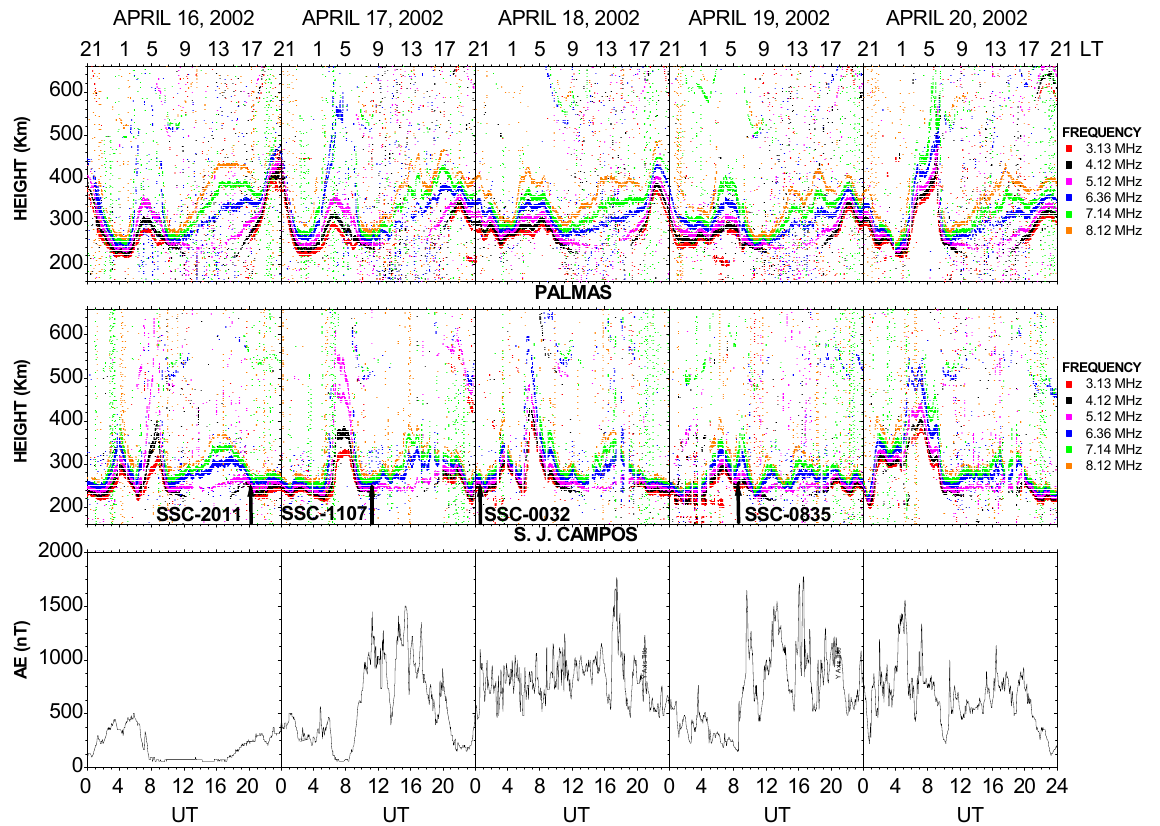
Fig. 5. Virtual height variation plots for different fixed frequencies (iso-frequencies) for the period 16–20 April 2002, observed at PAL (top) and SJC